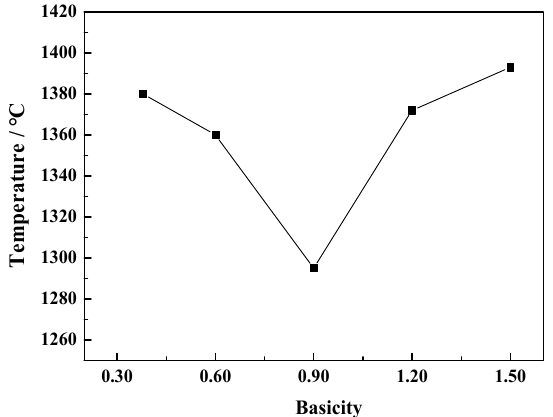
Figure 9. Relationship between basicity and critical viscosity temperature of the CaO-SiO 2 -FeO-MgO system.